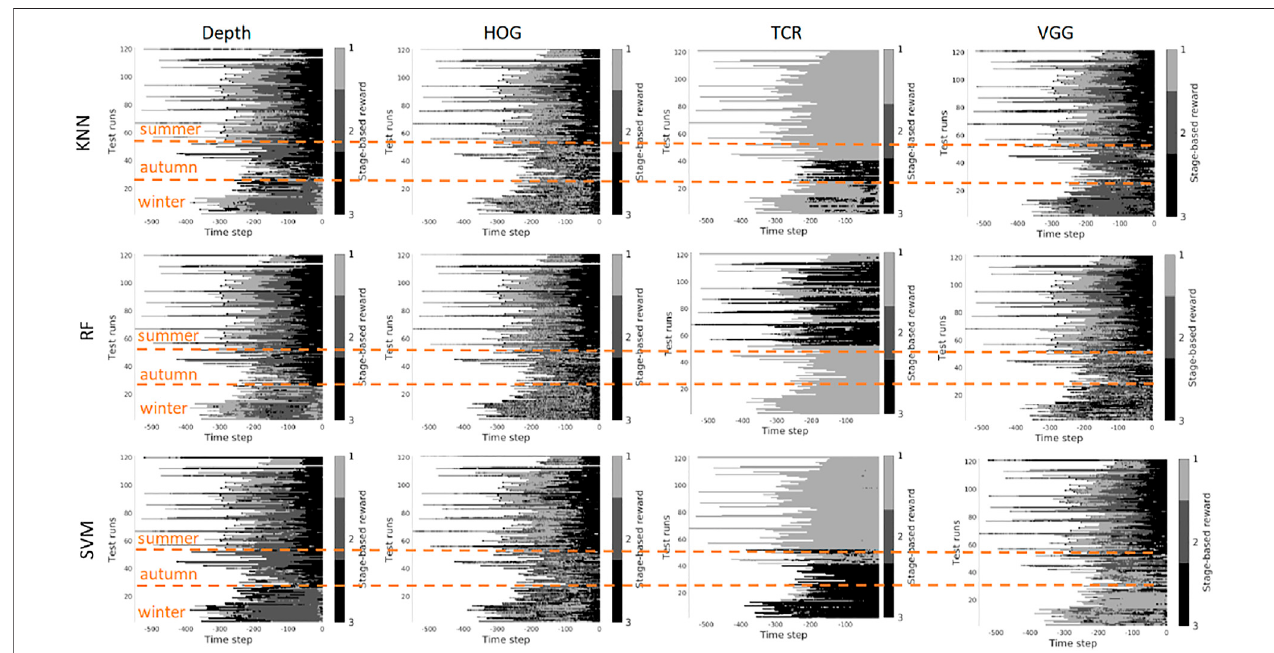
FIGURE 10 | Stage-based reward plotted for all seasons. Scenario 1: trained on the summer set of data D summer , 3 stages. The stages proceed as follows: S 1 − > S 2 − > S 3. x -axis stands for the time step in reversed order to match the samples of varying length. Color bar encodes the stages: S 1 - light gray, S 2 - gray, S 3 - black.